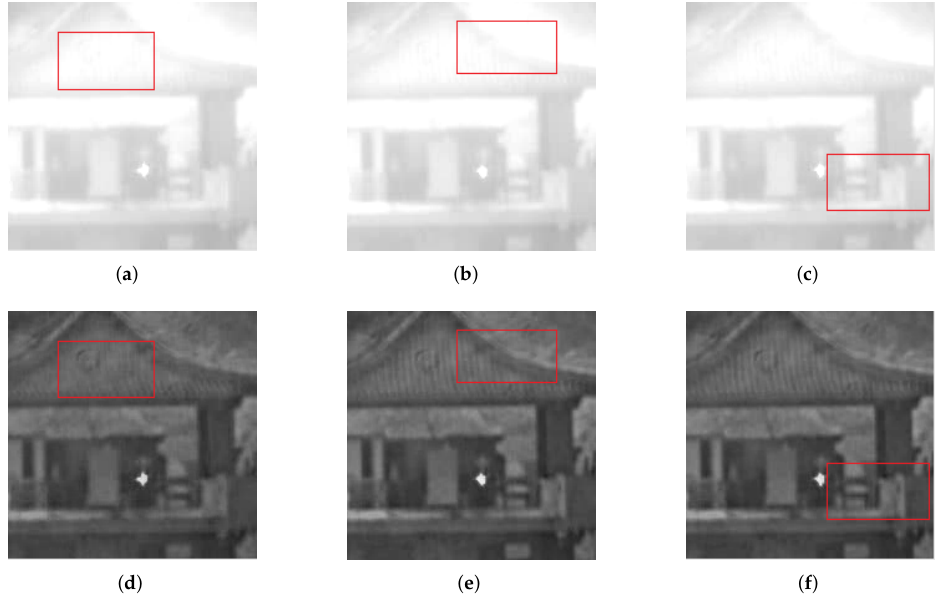
Figure 9. The tower in the actual video.